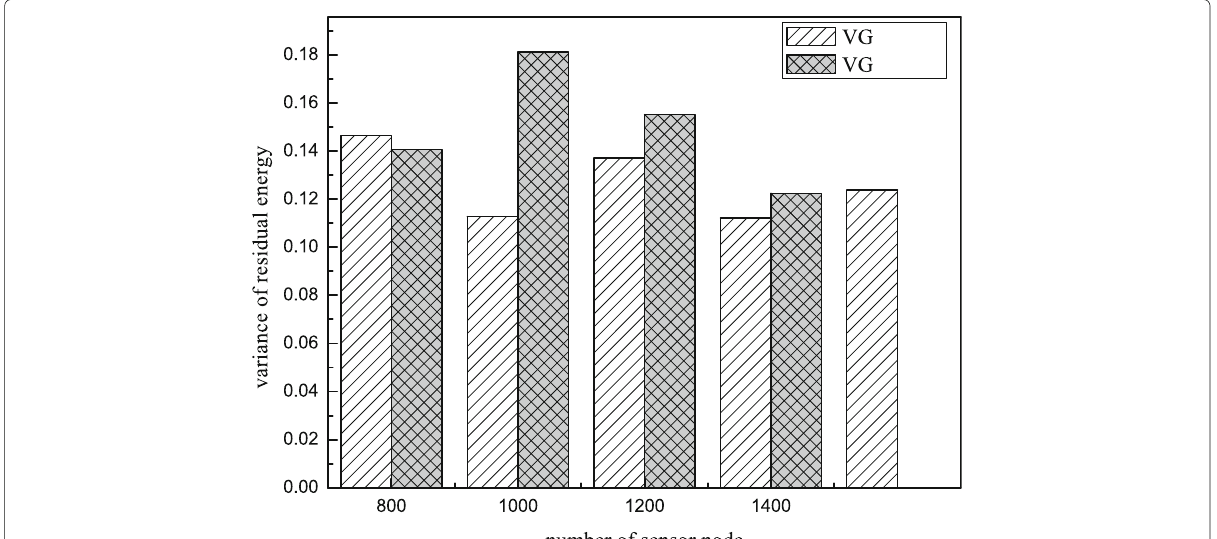
Fig. 14 The comparison of VGDD and VGDCA-C in a variance of residual energy. The energy consumption balance of the VGDCA-C was slightly better than that of the VGDD